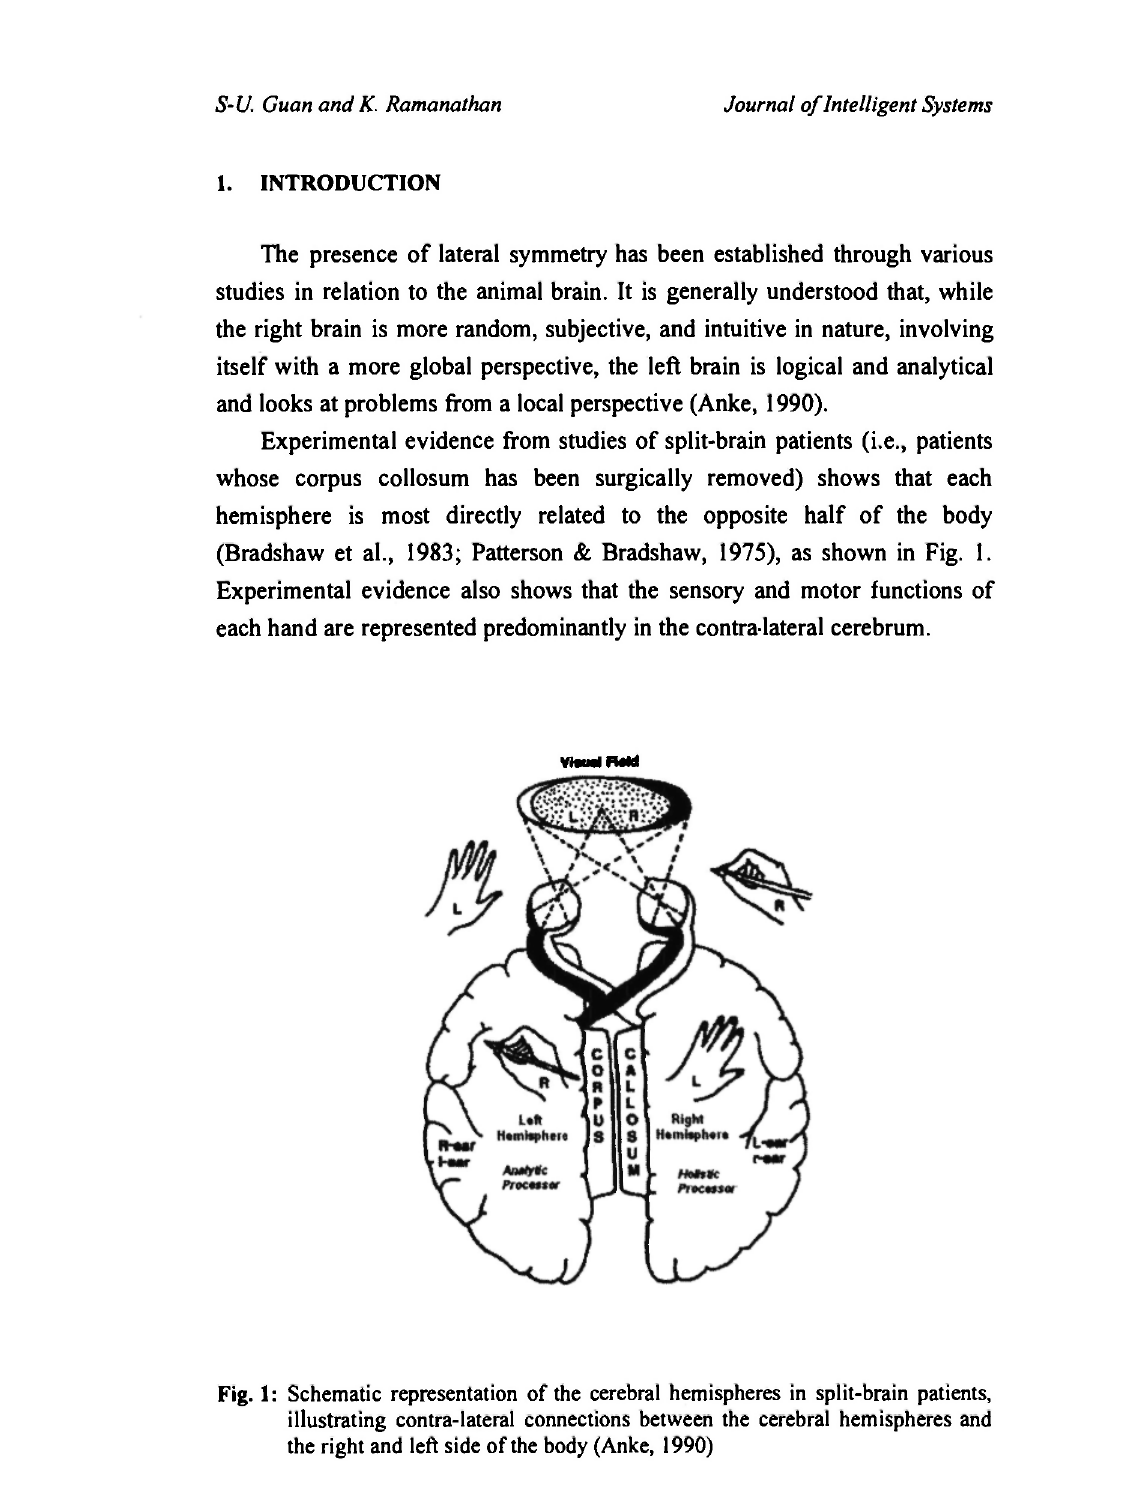
Fig. 1: Schematic representation of the cerebral hemispheres in split-brain patients, illustrating contra-lateral connections between the cerebral hemispheres and the right and left side of the body (Anke, 1990)